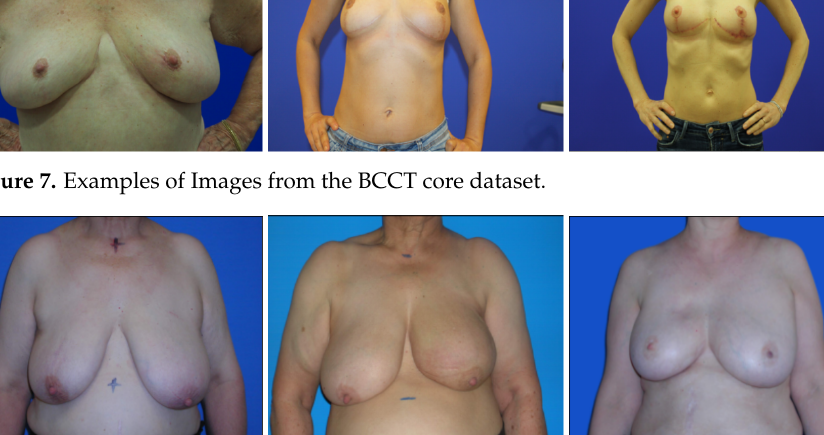
Figure 8. Examples of Images from the mixed dataset of 221